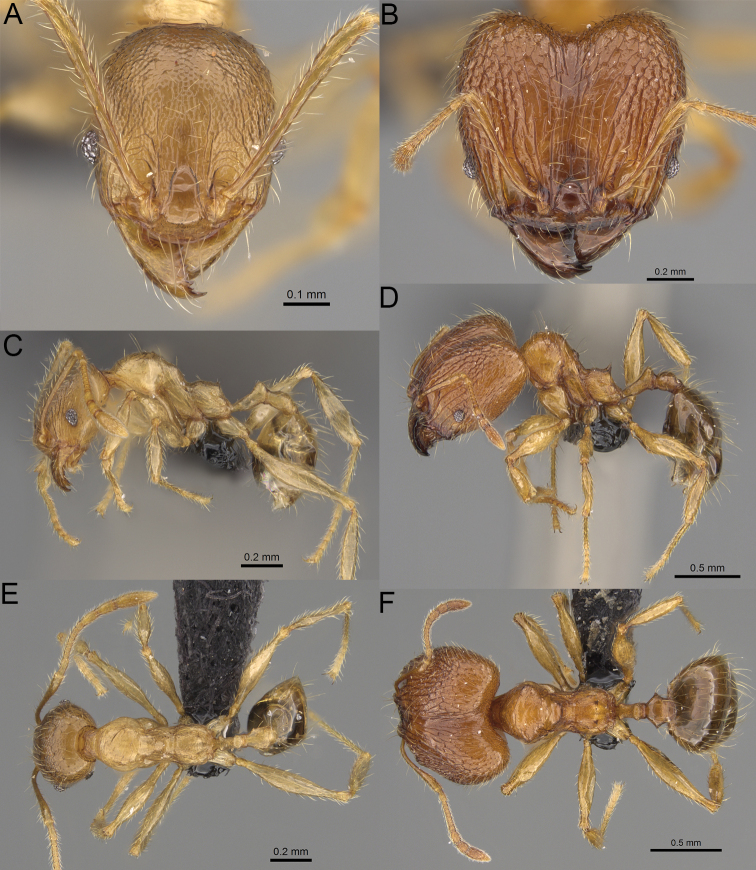
Pheidole
sikorae Forel, full-face view (A), profile (C), and dorsal view (E) of minor worker (CASENT0923322) and full-face view (B), profile (D), and dorsal view (F) of major worker (CASENT0149951).